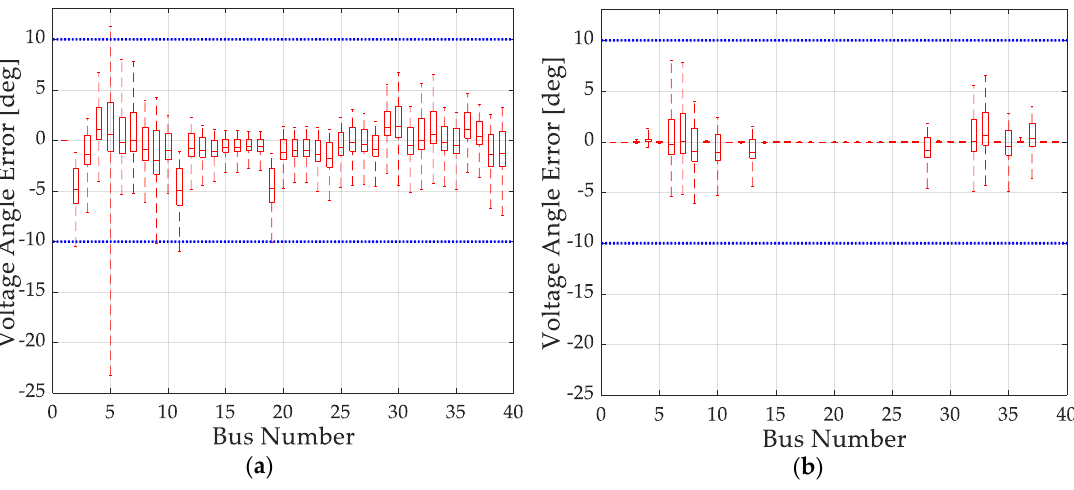
Figure 8. Statistical box plot of voltage angle estimation error in the BCS. ( a ) SCADA SE, ( b ) HSE. 5.3. CBI Estimation using Bus Voltage Phasor obtained by the Hybrid State Estimation (HSE) based on the PMU Placement